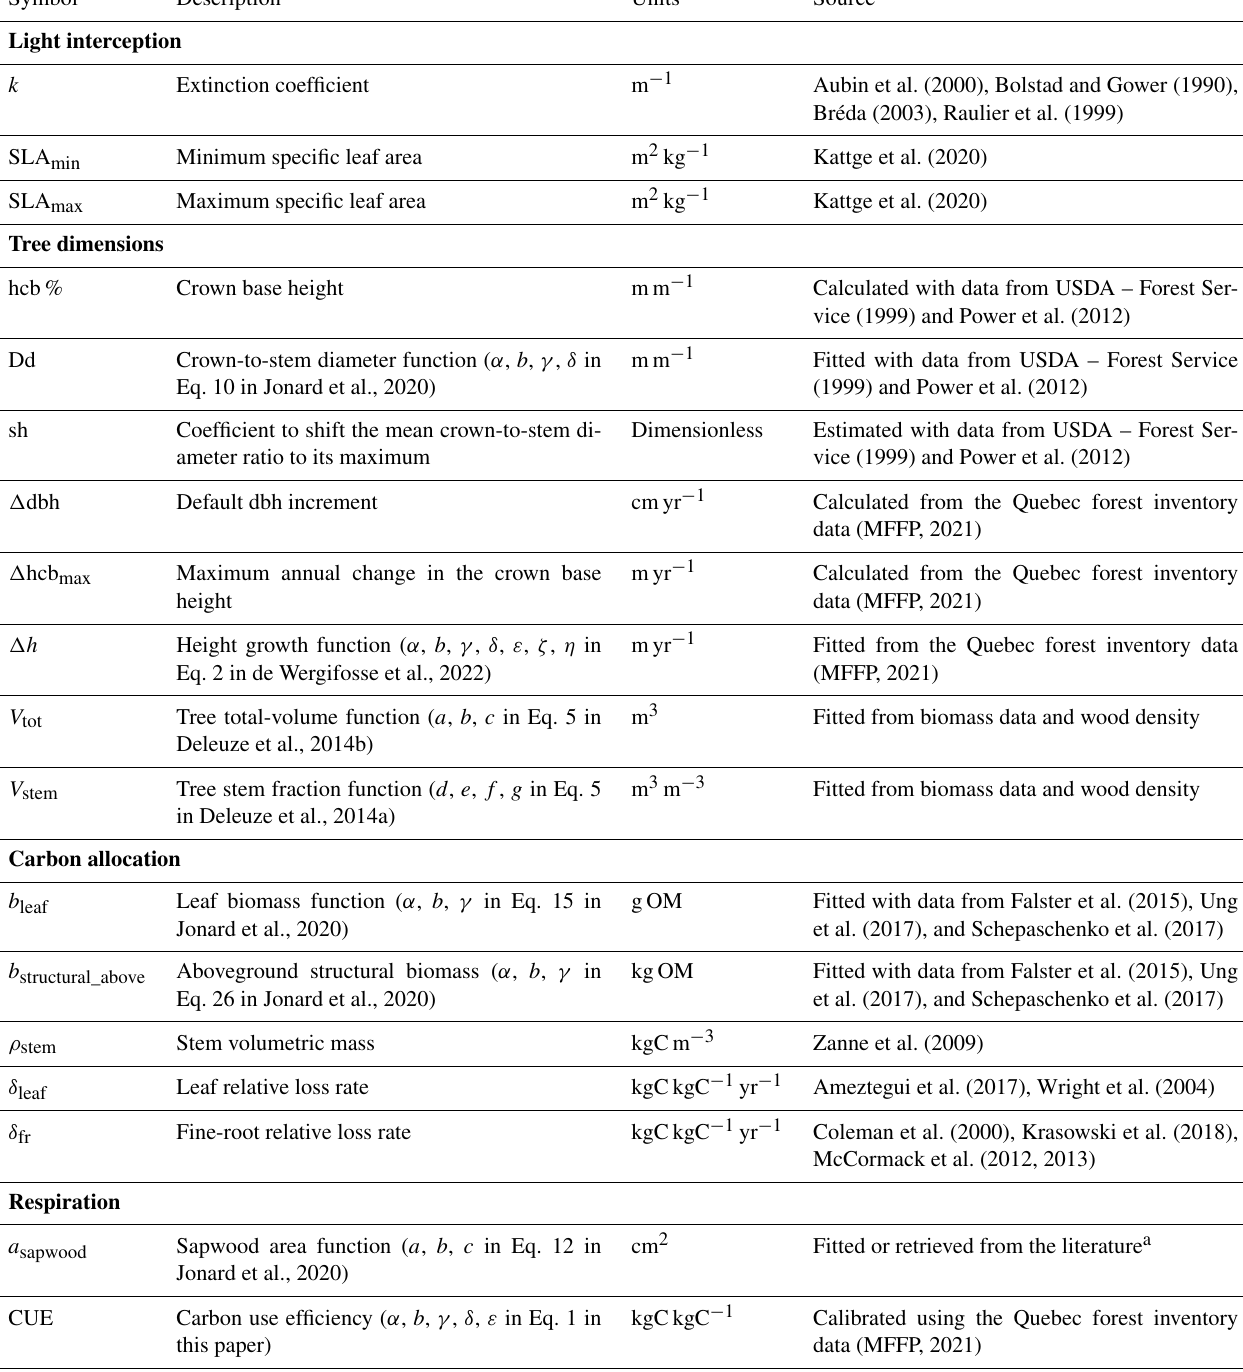
Table 2. Description of the species-specific parameters used in HETEROFOR (see Table S3 for the generic parameters).